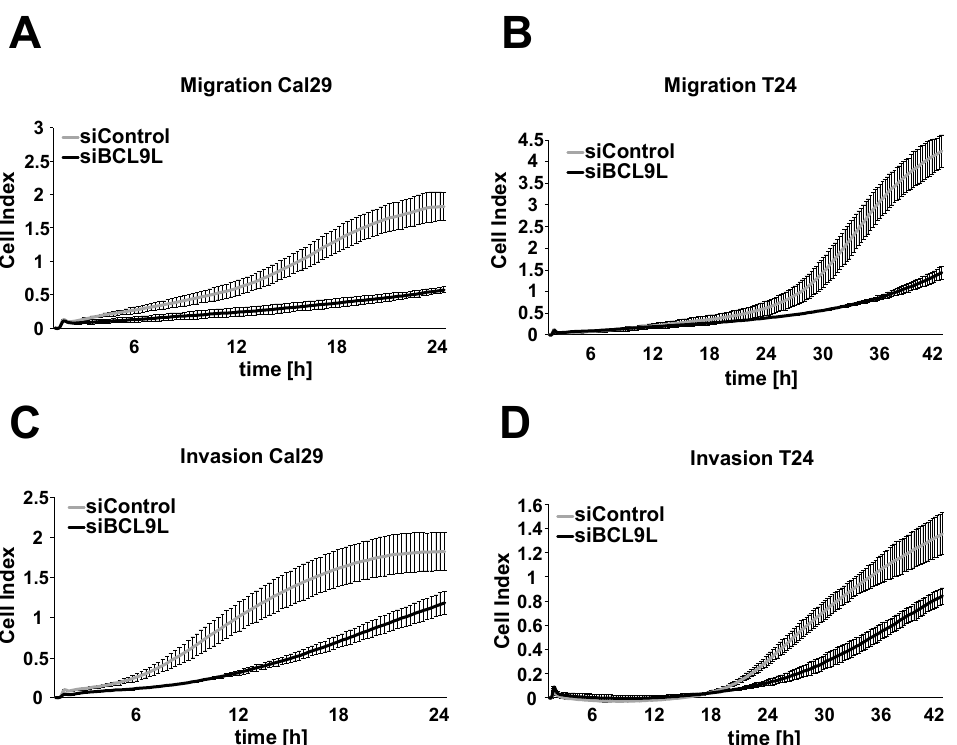
Figure 4. Knockdown of BCL9L represses migration and invasion of Cal29 and T24 cells. Transfected Cal29 ( A ) and T24 ( B ) cells with pooled siBCL9L or siControl were seeded on 16-well CIM plates, and the migration event was analysed in real-time by the xCELLigence system. Transfected Cal29 ( C ) and T24 ( D ) cells were seeded in the pre-coated with matrigel CIM plate and the invasion was analysed. The figure represents one of the biological replicates. All three independent biological replicates are shown in Supplementary Figure S4. The data are expressed as mean ± standard deviation of two technical replicates. The cell index values correspond to the cell number that migrates or invades.